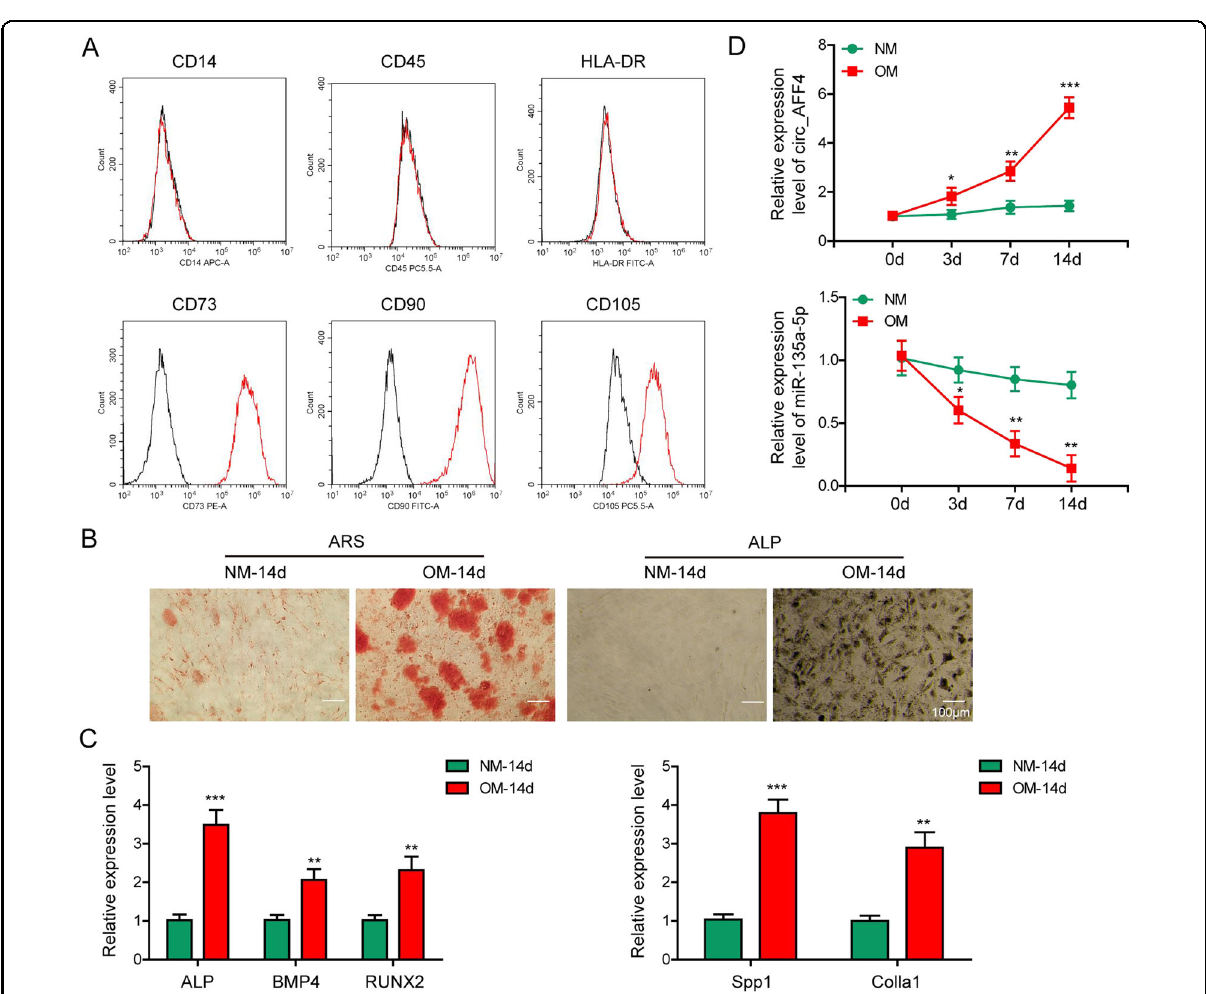
Fig. 1 Characterization of BM-MSCs and expression pro fi les of circ_AFF4, miR-135a-5p during osteogenic differentiation. A Expression of cell surface markers BM-MSCs was analyzed by FACS. Antibodies against CD14, CD45, HLA-DR, CD73, CD90, and CD105 were used to identify BM- MSCs. B ARS or ALP staining of BM-MSCs showed that osteogenic differentiation was ef fi ciently induced by using OM instead of NM. C qRT-PCR assay was performed to measure the mRNA expression of osteogenic marker genes ALP, BMP4, RUNX2, Spp1, and Colla1. D BM-MSCs were cultured in osteogenic medium (OM) or normal medium (NM). Relative expression of circ_AFF4 and miR-135a-5p was detected by qRT-PCR at days 0, 3, 7, and 14. The data were shown as mean ± SD based on at least three independent experiments. * P < 0.05, ** P < 0.01, and *** P <